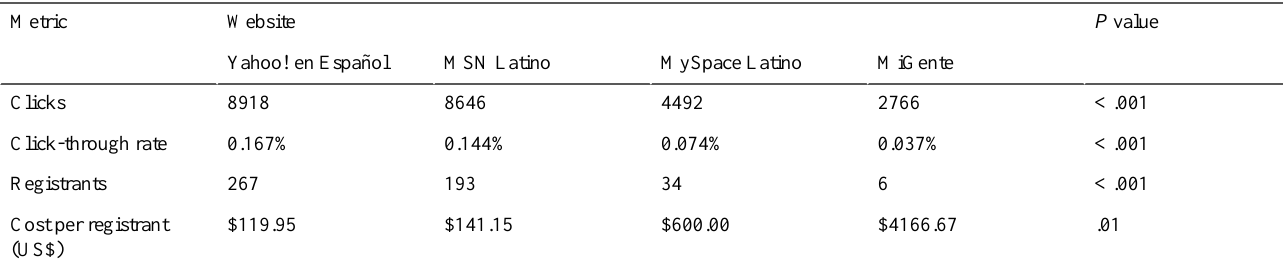
Table 2. Banner advertising results by website placement.